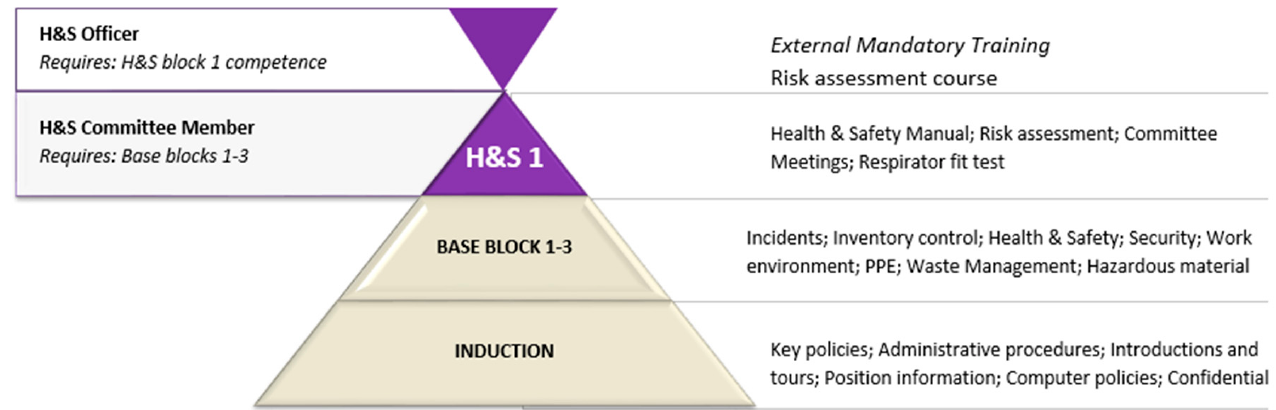
Figure 2. Training pathway for the Health and Safety committee members at KCMUCo ‐